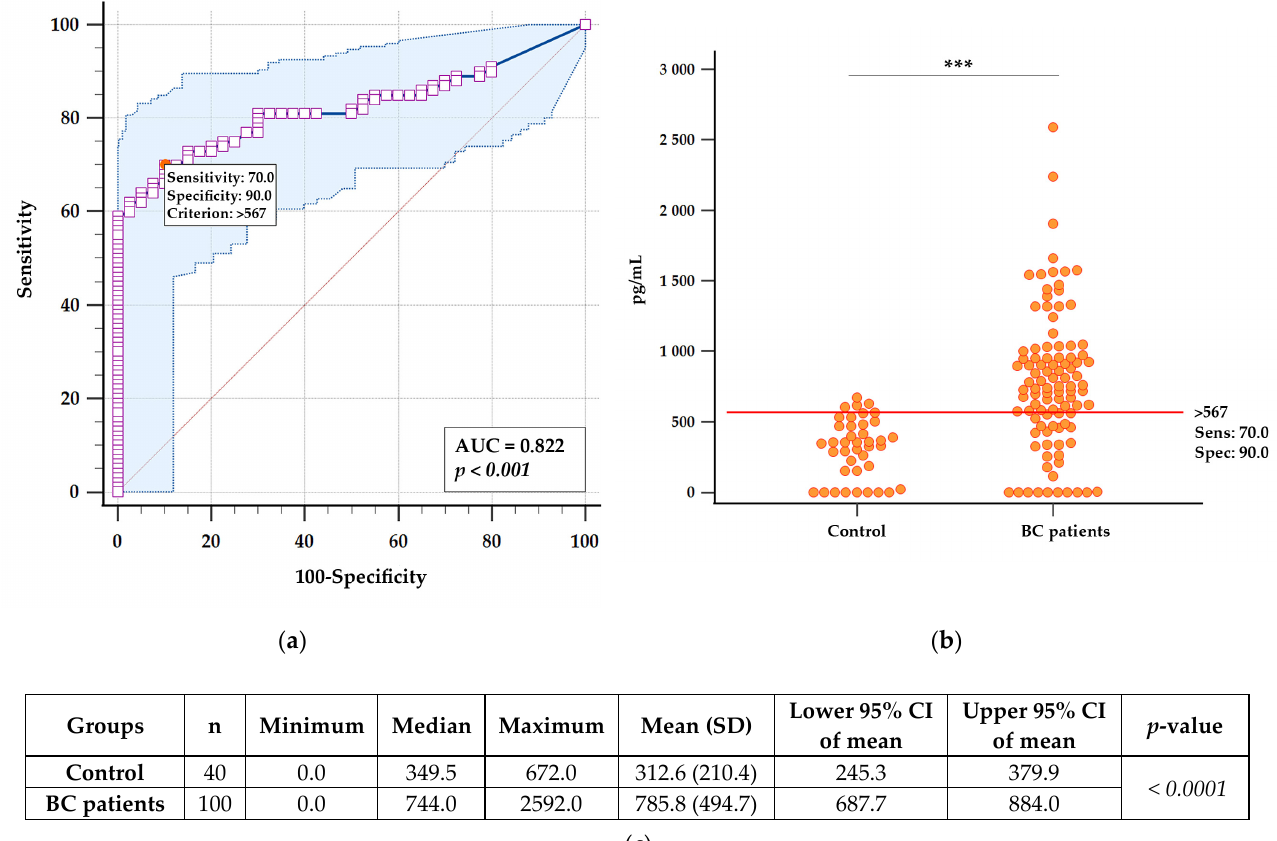
Figure 2. Receiver operating characteristic (ROC) curve analysis of CA IX ELISA: ( a ) ROC curve analysis was performed by MedCalc ® Statistical Software version 20.2 (MedCalc Software Ltd., Ostend, Belgium; https://www.medcalc.org (accessed on 1 October 2022); 2022) based on sCA IX values of BC patients included in the study versus healthy volunteers (n = 40). The software calculated the area under the curve (AUC), the statistical significance of the difference between the groups of healthy (Control) and tested BC patients ( p < 0.001 ), and determined the best cut off according to Youden’s statistic; ( b ) interactive dot diagram of measured levels of sCA IX in both groups with the cut off line (red horizontal line). The statistical significance of the difference between the groups of healthy (Control) and tested BC patients was evaluated by Mann–Whitney test for independent samples (*** Indicates significant effects with p< 0.0001 ); ( c ) the table shows summary statistical data of sCA IX (pg/mL) for each group: number of patients (n), minimum, median, maximum, mean with standard deviation (SD), lower 95% confidence interval (CI) for mean, upper 95% CI for median, and result of Mann–Whitney test for independent samples ( p< 0.0001 ).